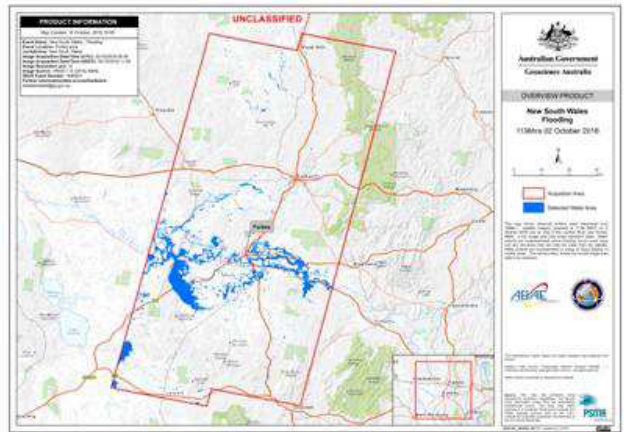
Figure N° 6: Mississippi river flooding, occurred on January 2, 2016; affecting to Louisiana State sector- southeastern United States, using VRSS.1 Figure N° 3: New South Walles Flooding – Australia, Oct, 2016, using VRSS.1